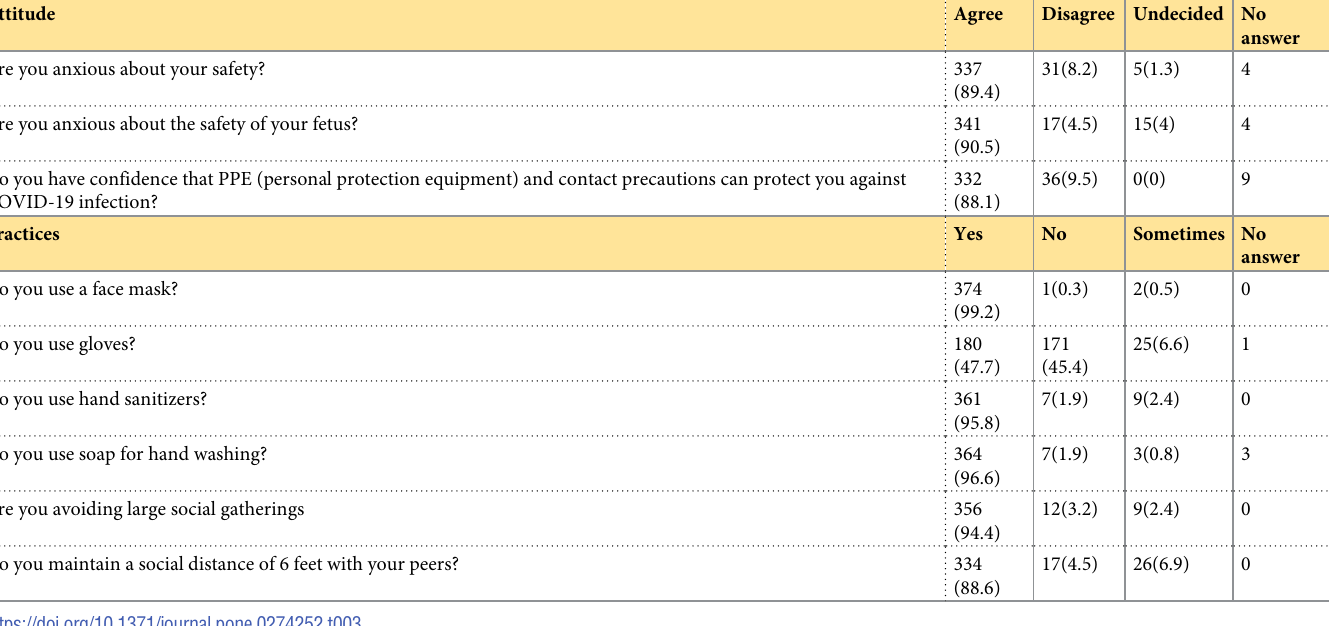
Table 3. Women’s attitude and practice related to COVID 19 [n = 377].